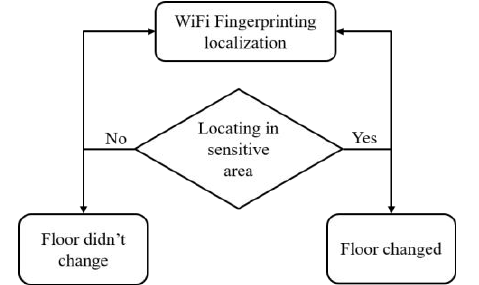
Figure 2. Sensitive area based floor change detection method.